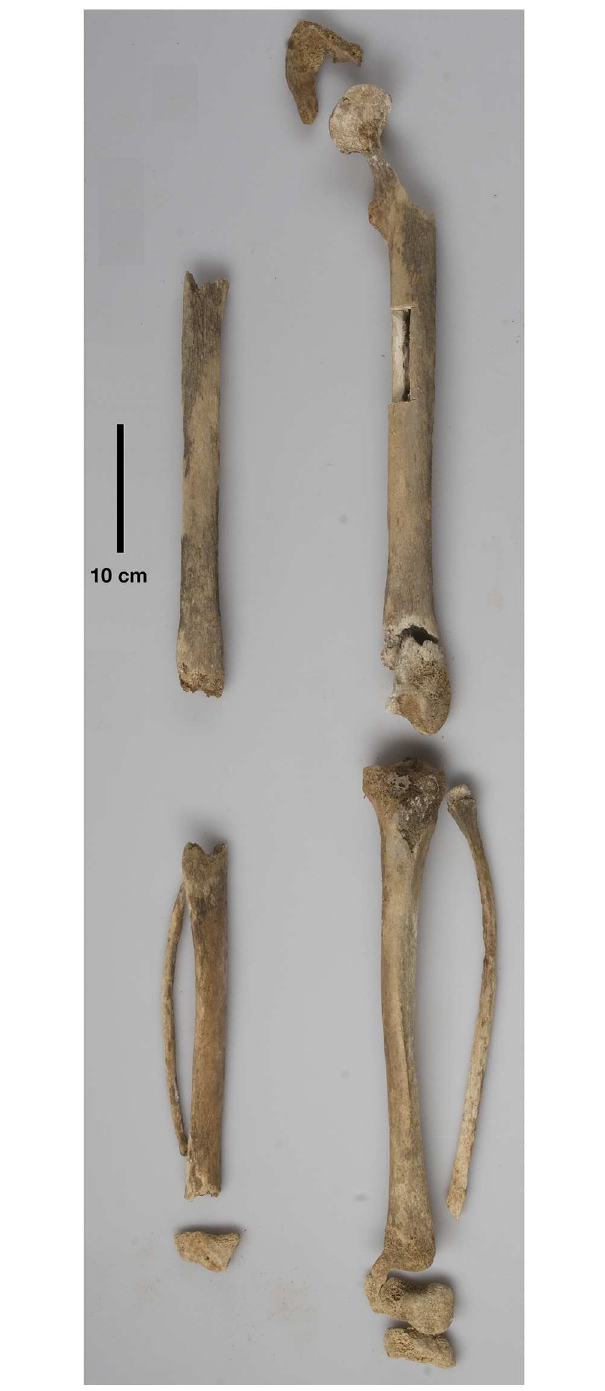
Fig 3. The preservedbones of the lower extremities. The 7 x 2 cm large defect in the left femoral shaft resultedfrom DNA sampling.Scale bar 10 cm.